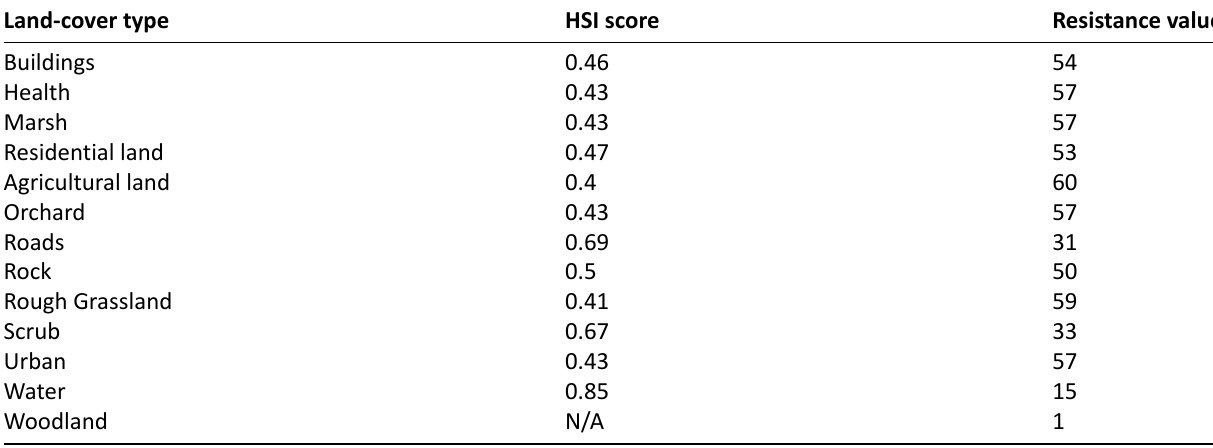
Figure 3. Landscape networks for Eurasian jays: (a) habitat network; (b) home-range network. Table 2. HSI scores obtained from MaxEnt and the corresponding resistance